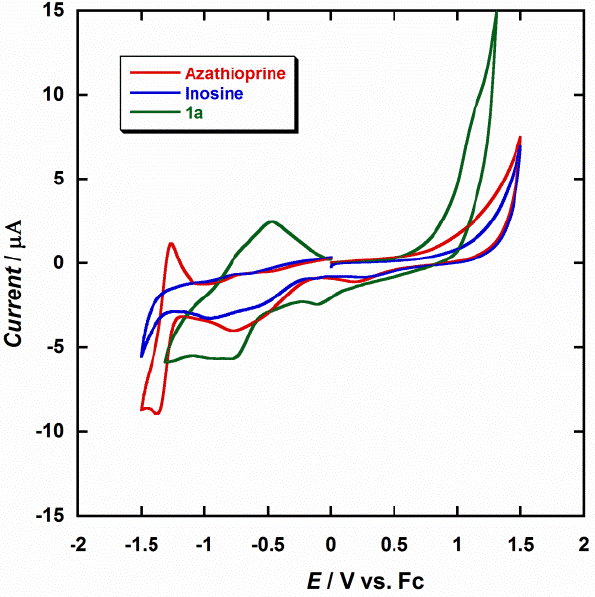
Figure 4. Cyclic voltammograms of 1a (green), inosine (blue) and azathioprine (red) in dry dmf (0.1 M NBu 4 PF 6 ) at 25 ◦ C and scan rate 200 mV/s.